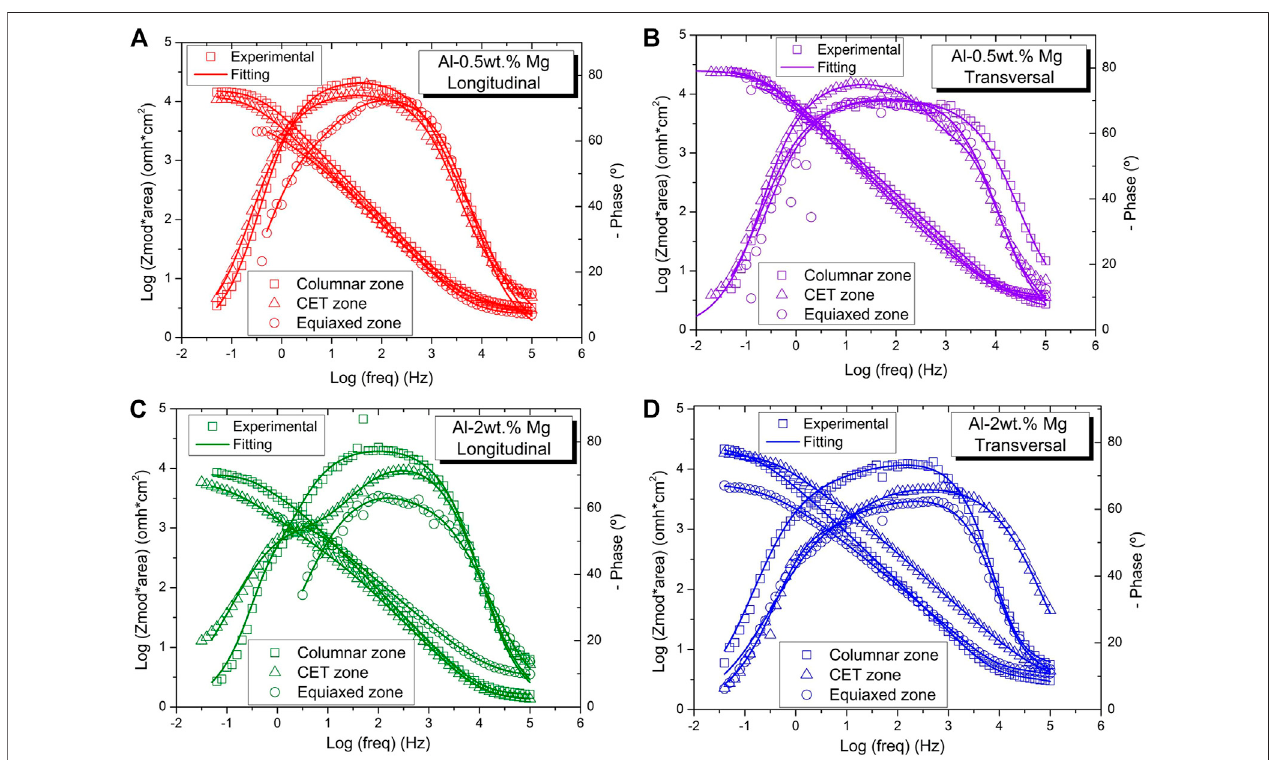
FIGURE9| BodediagramsofAl-Mgalloys. (A) Al-0.5wt.%Mgalloy(longitudinal). (B) Al-0.5wt.%Mgalloy(transversal). (C) Al-2wt.%Mgalloy(longitudinal). (D) Al- 2wt.% Mg alloy (transversal).